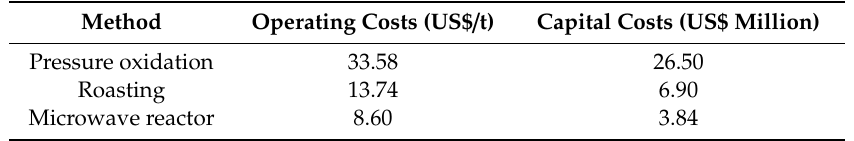
Table 5. Economic comparation of microwave reactor with pressure oxidation and roasting method for the treatment of refractory gold (200 t / day concentrate from 2000 t / day operation)